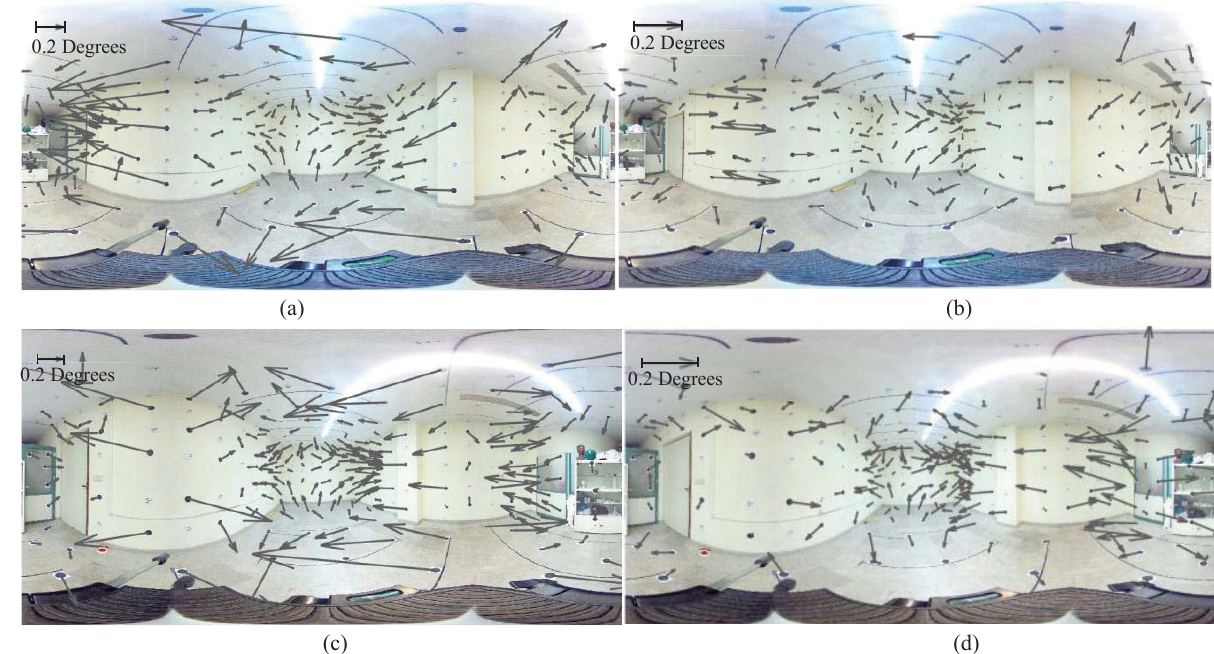
Figure 8. Residuals vector of all control points in image space before (a and c) and after (b and d) calibration for dataset1 (a and b) and dataset 2 (c and